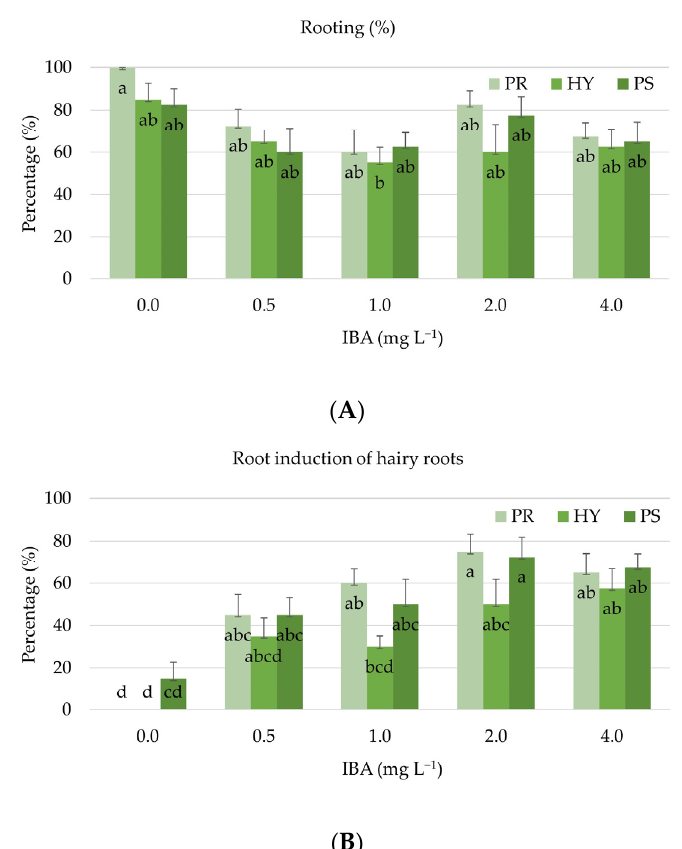
Figure 4. Effect of indole − 3-butyric acid (IBA) concentration on root induction of micro-shoots from three C. candidissimum populations—Parnitha (PR), Hymettus (HY) and Parnassos (PS)—on half-strength Murashige and Skoog media: ( A ) rooting percentage (%); ( B ) induction of hairy roots (%). Two-way ANOVA results for root induction, comparison of LS means with Tukey’s HSD: F population × IBA ns, F population ns, F IBA ***; two-way ANOVA results for induction of hairy roots: F population × IBA ns, F population **, F IBA ***; mean values followed by the same letter are not significantly different at p < 0.05; ns: non-significant at p ≤ 0.05; **, ***: significant at p ≤ 0.01, p ≤ 0.001, respectively; n = 40; standard errors of the means are shown in each bar graph.